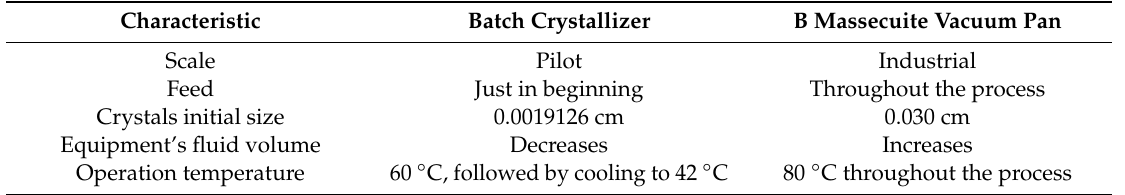
Table 1. Di ff erences between batch crystallization and B massecuite